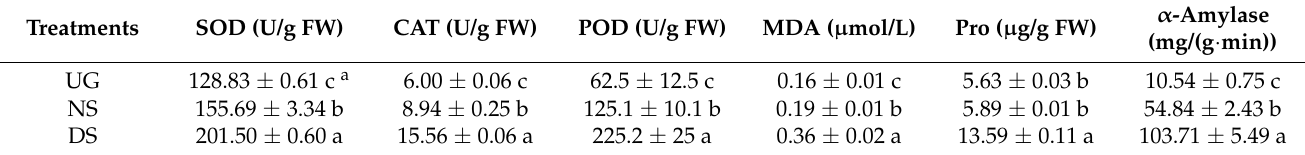
Table 1. Effect of deep-sowing on physiological changes in maize embryos.